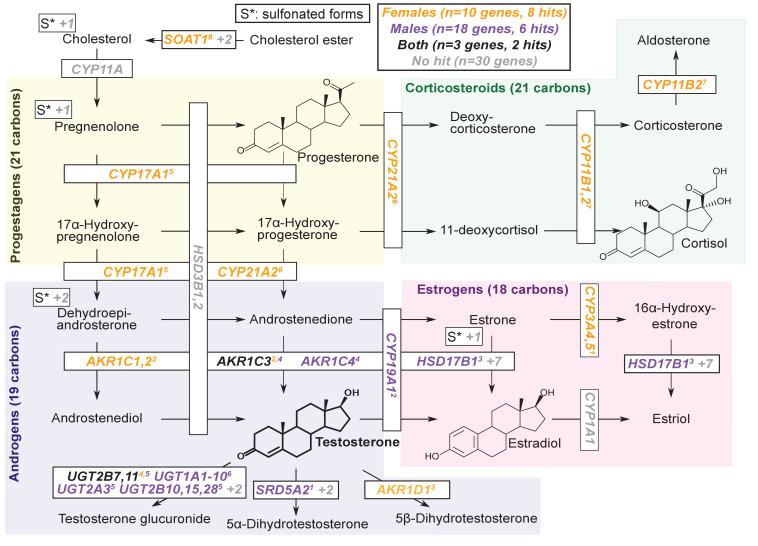
Pathway diagram for steroid hormone biosynthesis showing GWAS hits for females and males.The text color indicates genes within 100 kb of a genome-wide significant hit for females (orange), males (blue), or both females and males (black). Gray gene names or numbers indicates genes with no hits. Colored superscripts indicate multiple genes from the same locus (and hence may reflect a single signal). ‘S*’ indicates that an additional, sulfonated metabolite, along with the catalytic step and enzymes leading to it, is not shown. Pathway from KEGG; simplified based on a similar diagram in Wikipedia, 2012.